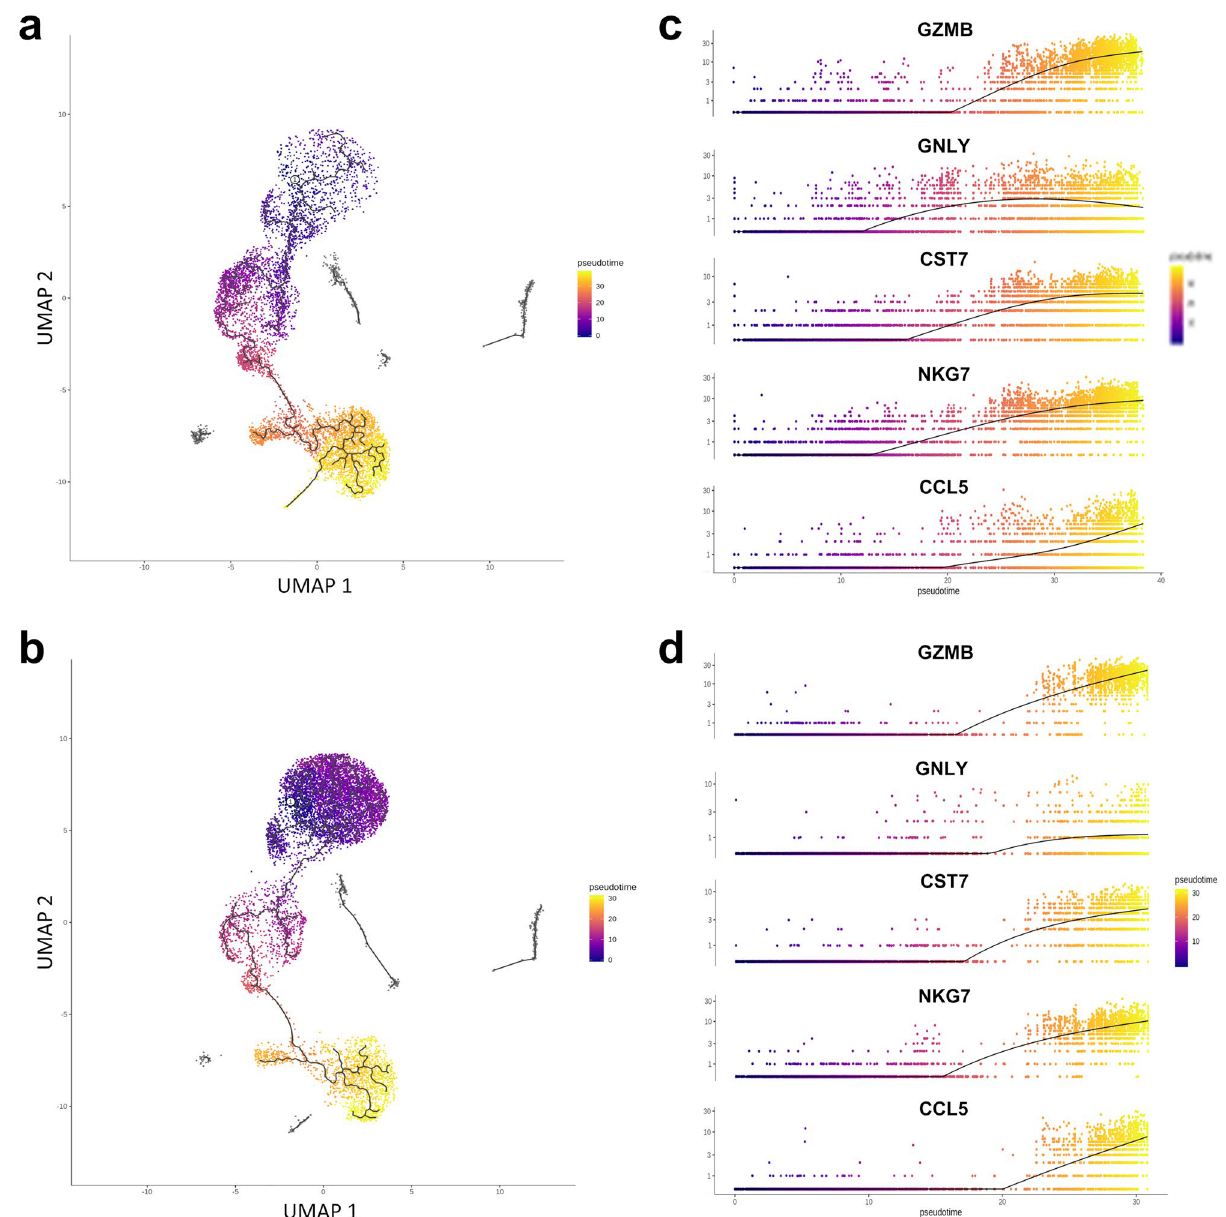
Figure 3. ( a, b ) UMAP visualizing the pseudotime trajectory of the aggregated dataset for DP T cells from ( a ) the rhesus and ( b ) a cynomolgus monkey. Black lines on the UMAP represent the trajectory graph. ( c, d ) Spline plots representing expression of genes with large transitions along the pseudotime in ( c ) the rhesus monkey and ( d ) the cynomolgus monkey. All plots were generated using Monocle3